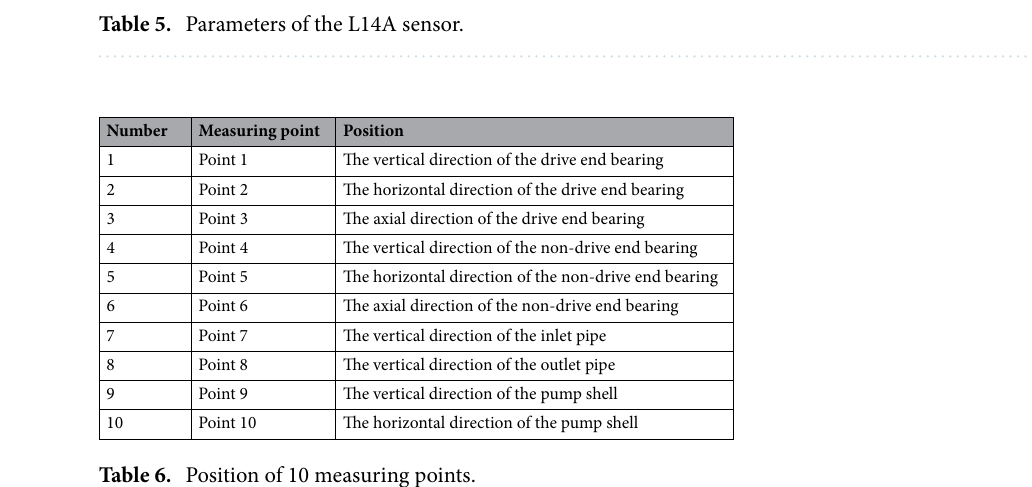
Table 6. Position of 10 measuring points.